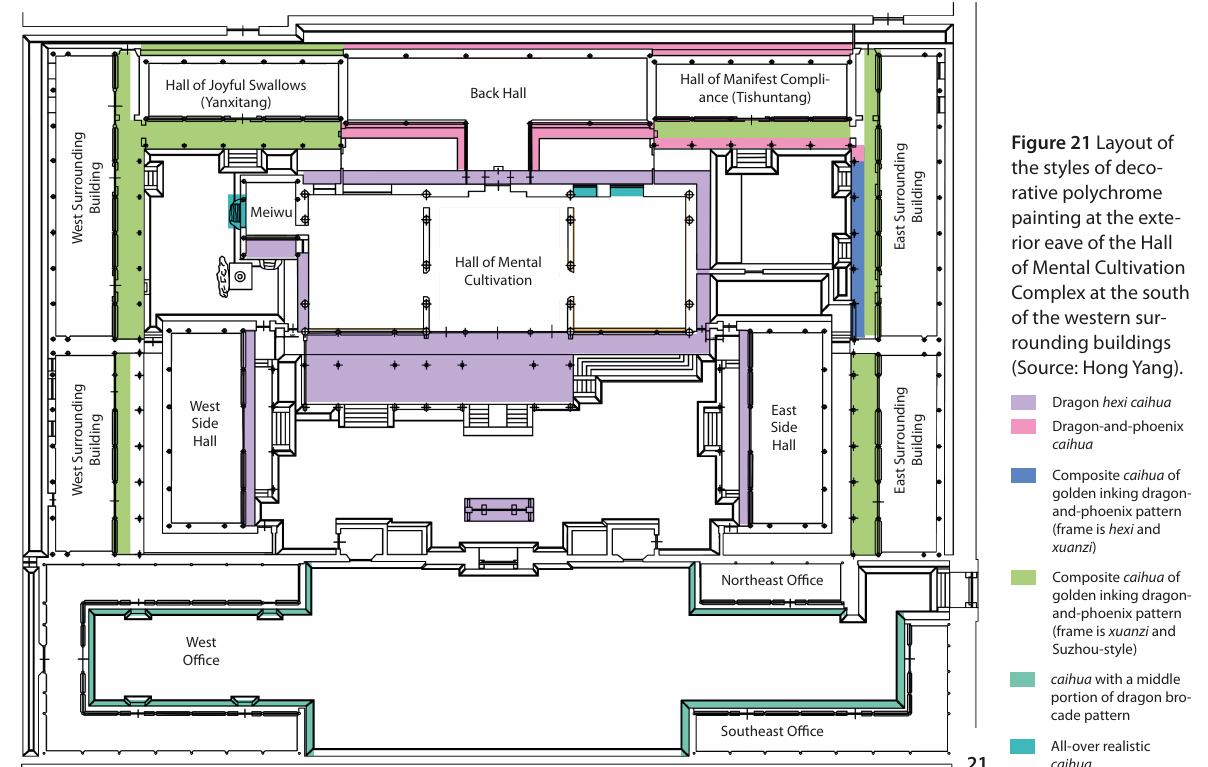
Figure 21 Layout of the styles of deco- rative polychrome painting at the exte- rior eave of the Hall of Mental Cultivation Complex at the south of the western sur- rounding buildings (Source: Hong